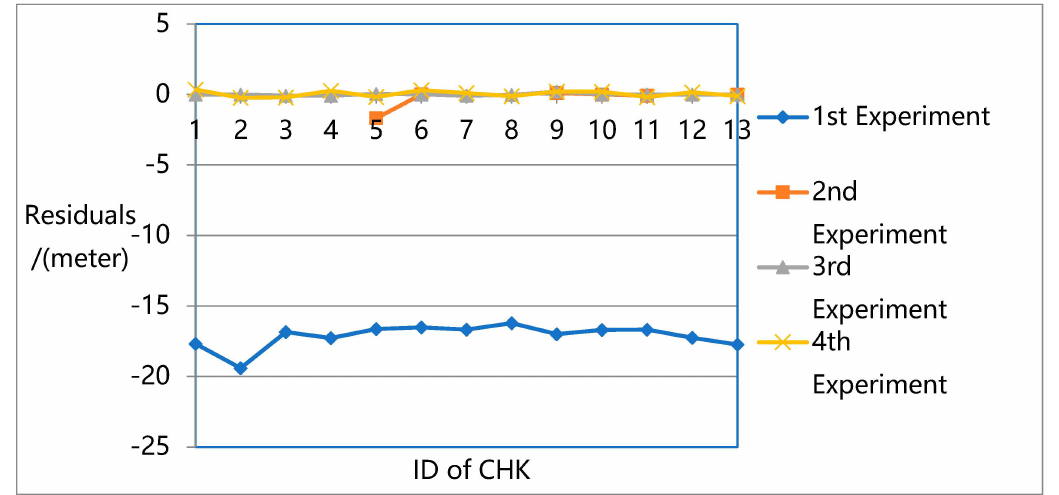
Figure 14. Residuals Plot of CHKs in Y-direction.